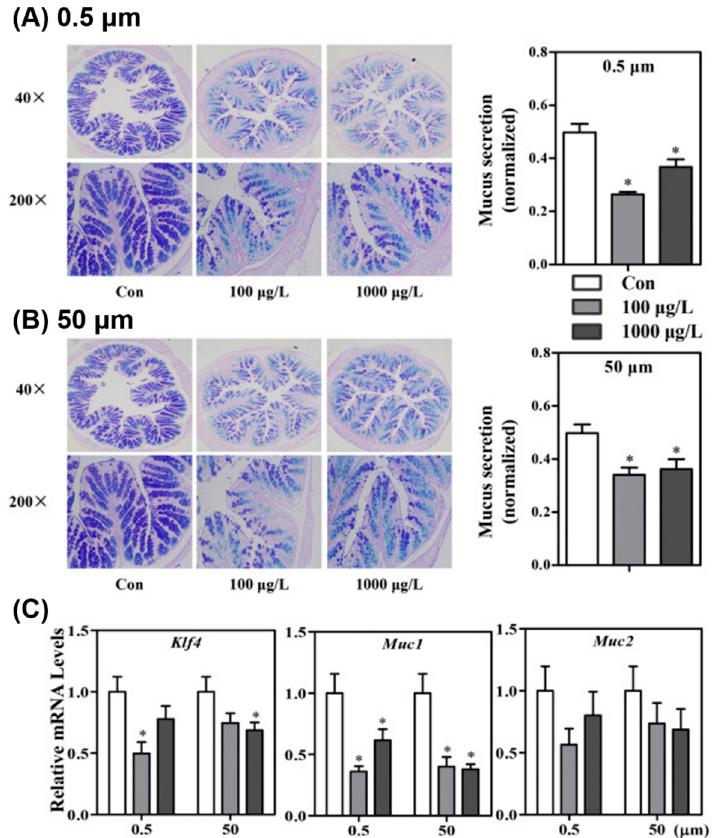
Figure 12. Effects of PS MPs exposure on mucus secretion in the gut. After alcian blue/periodic acid–Schiff (AB-PAS) staining, mucus secretion was normalized using the ratio of the mucus secretion area to the entire colon area. Institute of Cancer Research (ICR) mice were treated with ( A ) PS MPs (0.5 μ m) and ( B ) PS MPs (50 μ m) at two different concentrations. ( C ) The transcription levels of three genes related to mucin secretion in the colon are shown. The presented values are the means ± standard deviation (n = 8). * P < 0.05 versus control [22]. (Reprinted with permission from [22]. Copyright 2017 Elsev.)